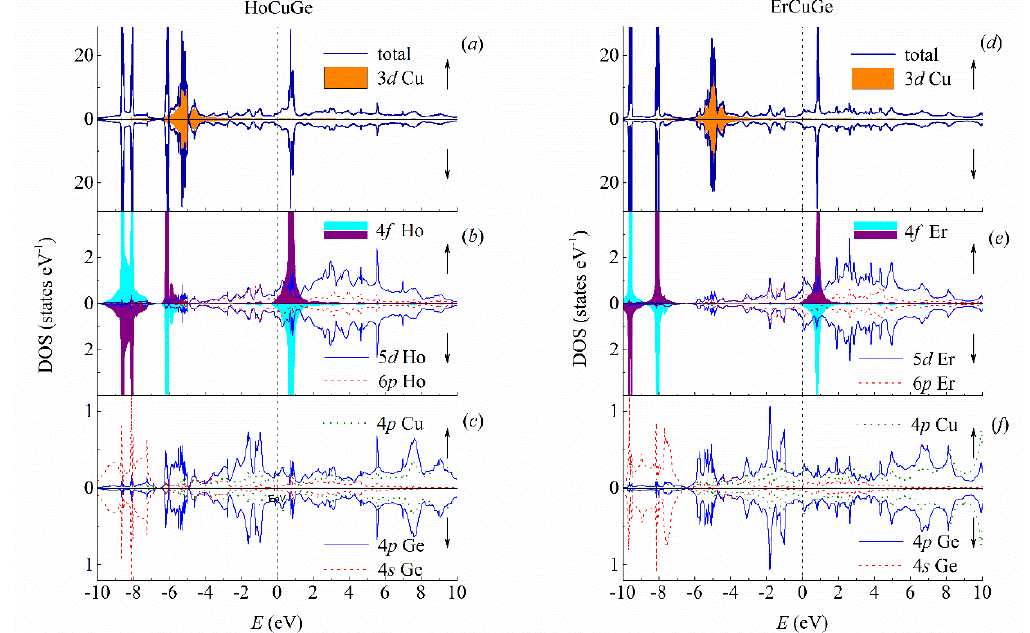
Figure 3. Calculated ab initio densities of states of HoCuGe and ErCuGe. ( a ) Total density of states of HoCuGe and Cu-3d densities; ( b ) densities of states for Ho-4f, Ho-5d and Ho-6p; ( c ) densities of states for Cu-4p, Ge-4p and Ge-4s in HoCuGe; ( d ) total density of states of ErCuGe and Cu-3d densities; ( e ) densities of states for Er-4f, Er-5d and Er-6p; ( f ) densities of states for Cu-4p, Ge-4p and Ge-4s in ErCuGe. Dashed vertical lines show Fermi energy.